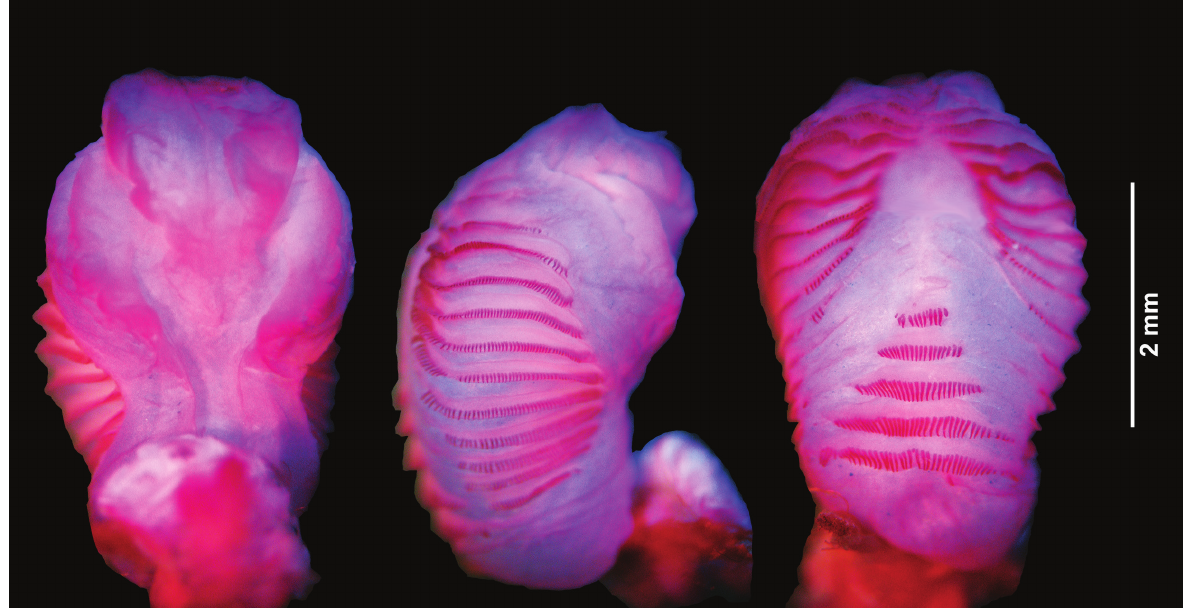
Figure 4. Left hemipenis of Selvasaura evasa sp. nov. (CORBIDI 15119 – holotype) in sulcate (left), lateral (middle), and asulcate (right) views. Photographs by